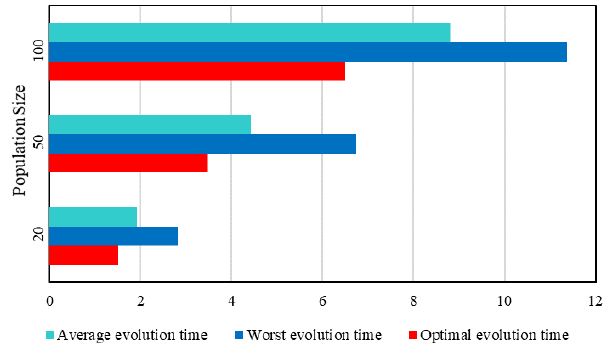
Figure 7. The relation of Population Size and Convergence